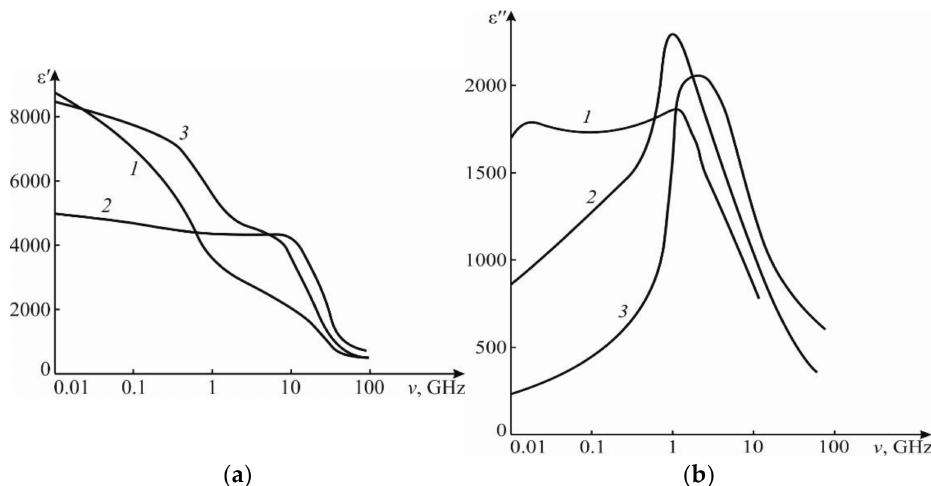
Figure 7. Microwave dielectric dispersion in lead magnesium niobate (PMN) = PbMg 1/3 Nb 2/3 O 3 at the temperatures of 1–290, 2–300, and 3–320 K: ( a ) permittivity ε (cid:48) ; ( b ) loss factor ε ”